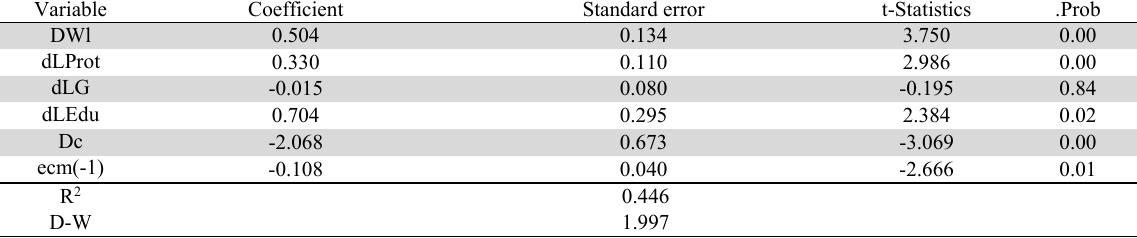
The Error Correction Mechanism without time trend Variable